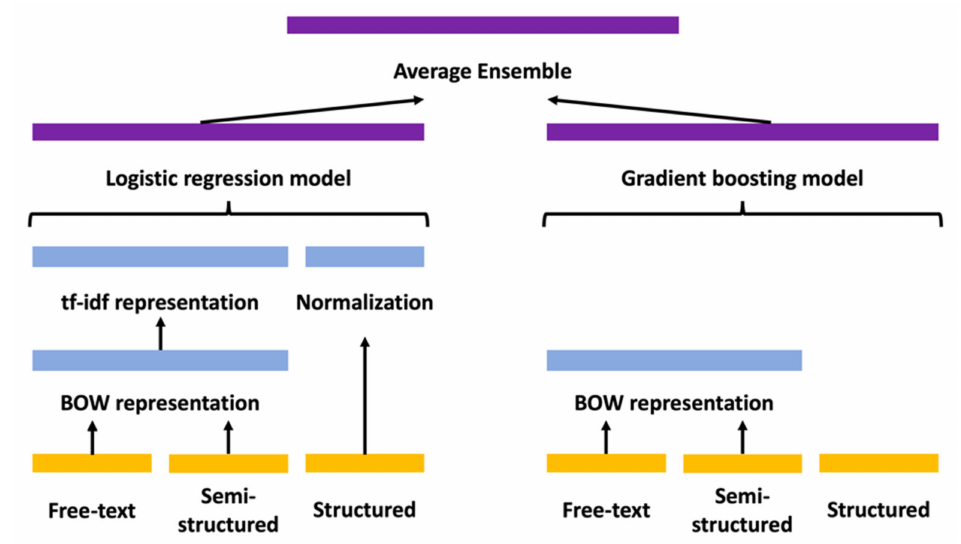
Figure 1. Schematics of the models’